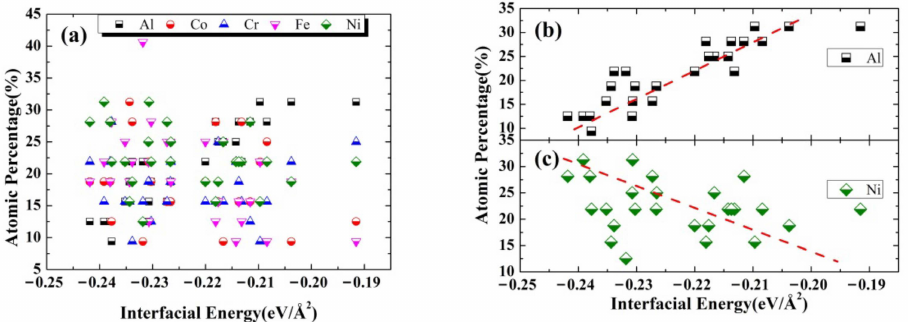
Figure 6. The calculated interfacial energy of Al (001)/AlCoCrFeNi (001) against chemical composi- tions of ( a ) all constituent alloy elements, ( b ) Al, and ( c ) Ni in the interfacial regions.